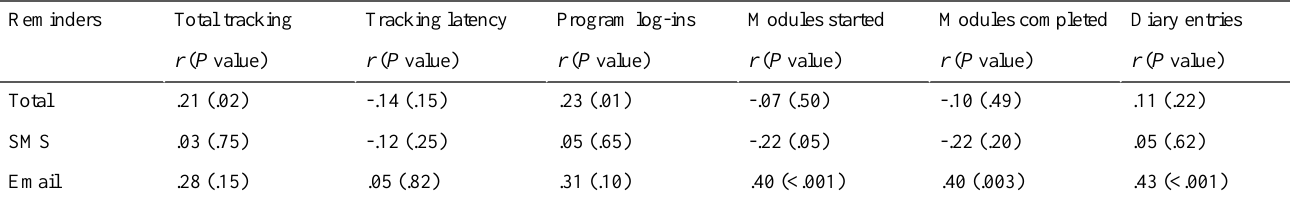
Table 4. Correlations between usage